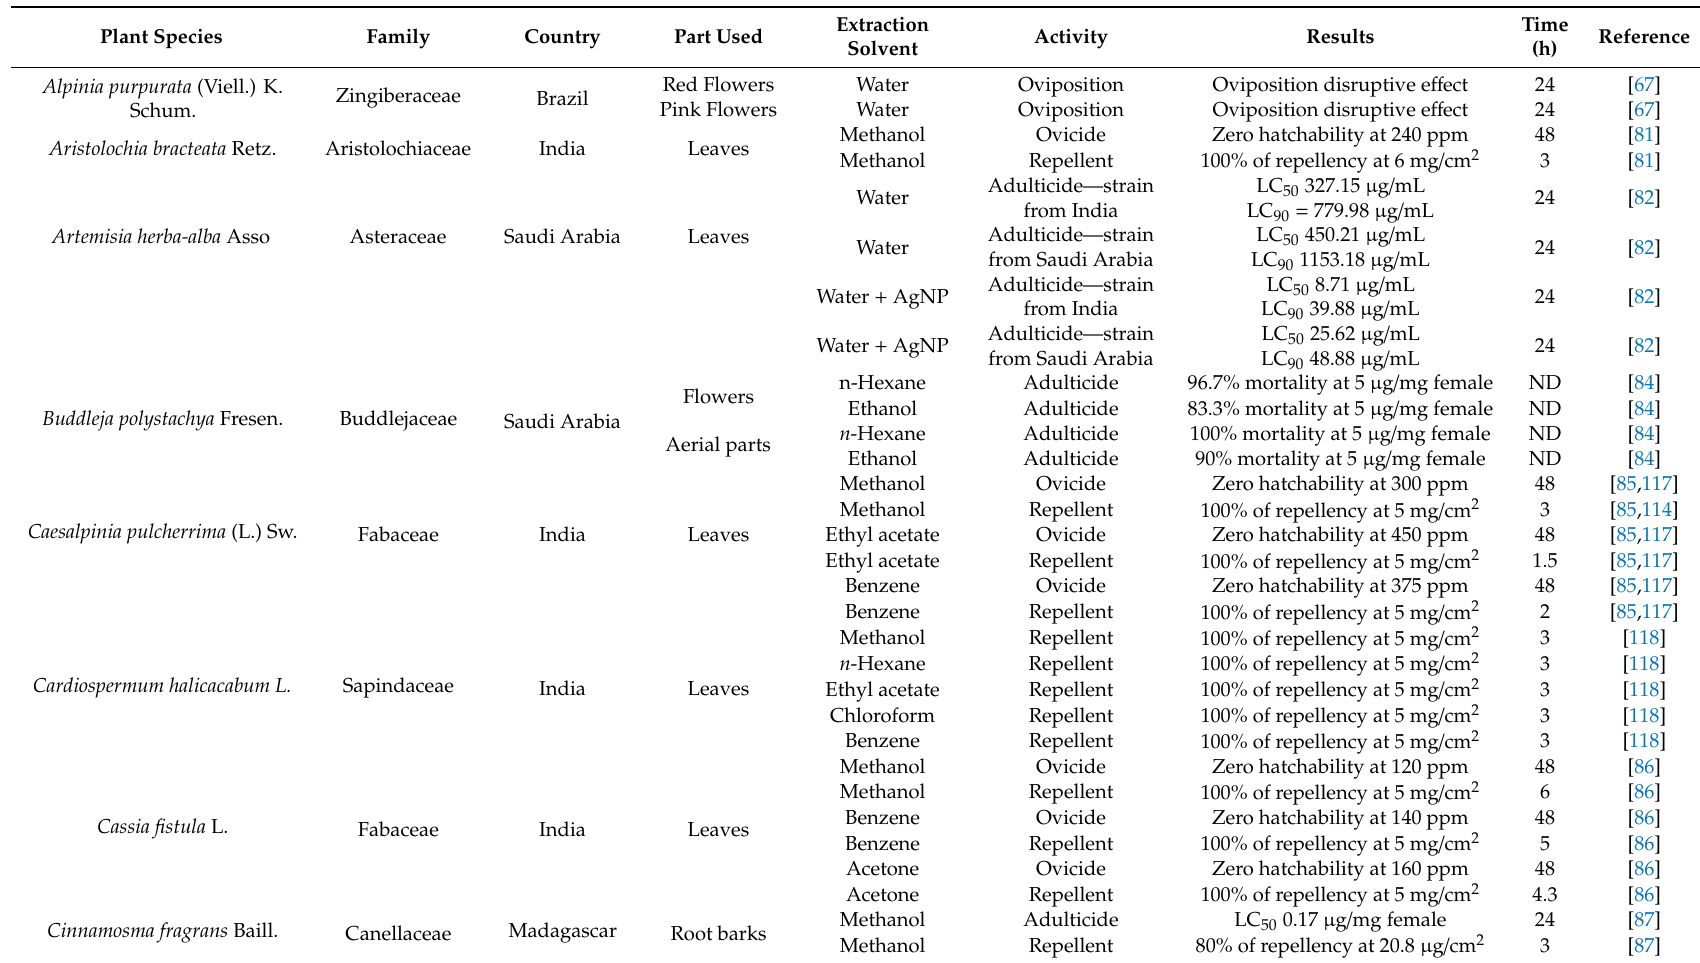
Table 4. Adulticidal, pupicidal, ovicidal, repellent and oviposition activities of organic / aqueous extracts against the Ae. aegypti mosquito. Plant Species Family Part Used Alpinia purpurata (Viell.) K.